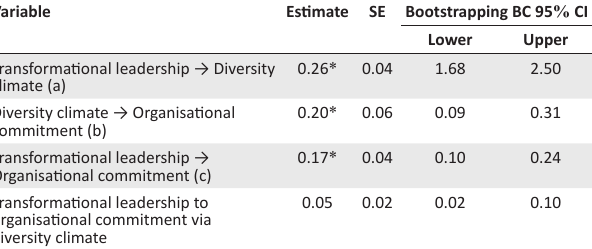
TABLE 4: Standardised regression coefficients of the variables: Transformational leadership, diversity climate and organisational commitment. Variable